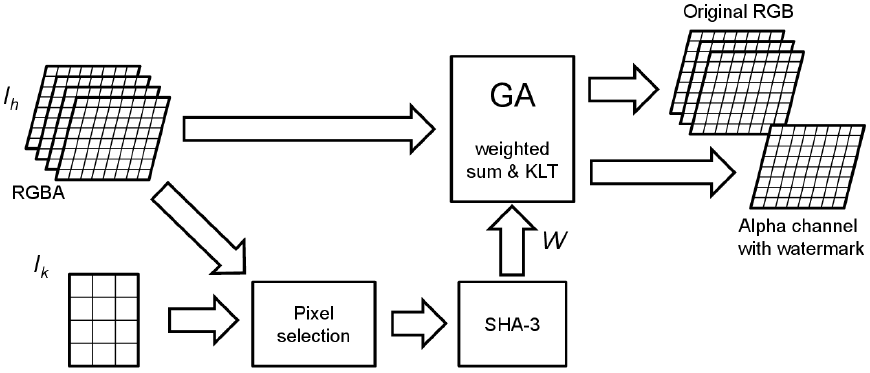
Figure 4. Diagram showing the main elements involved in watermark generation.